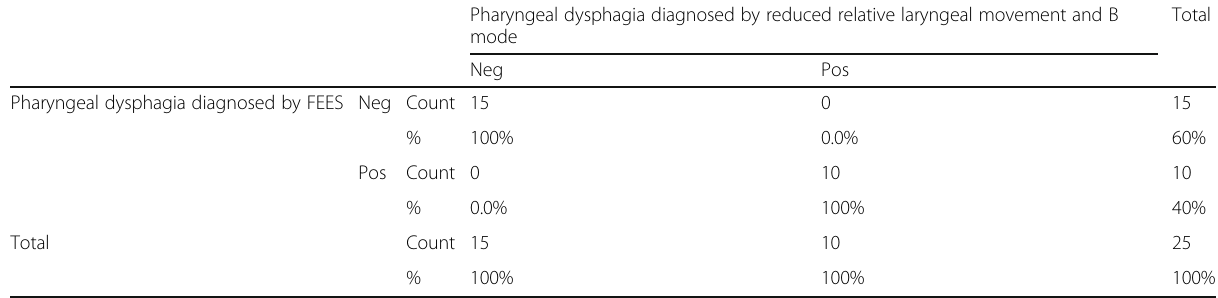
Table 3 Pharyngeal dysphagia diagnosed by US, including both the reduced relative laryngeal movement ( ≤ 40%) and the B mode as compared to FEES which was used as the reference